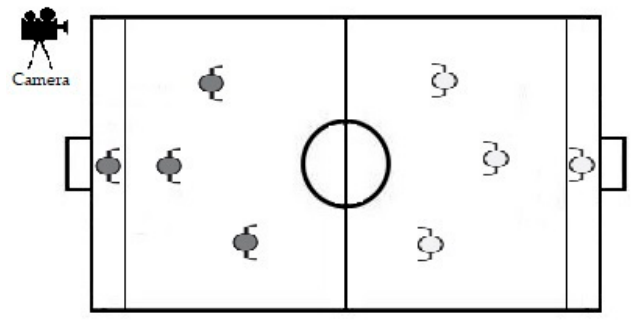
Figure 2. Play situation 3vs3 (+ goalkeepers).